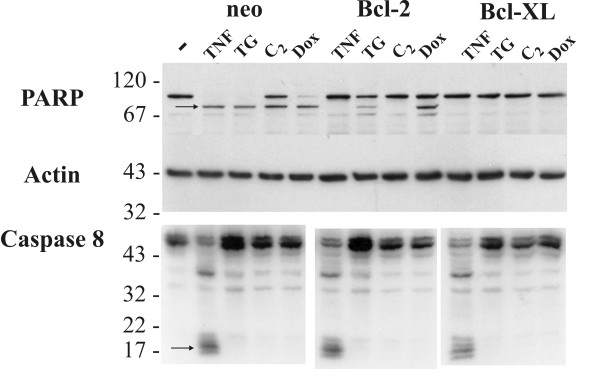
Prevention of apoptosis by Bcl-2 and Bcl-XL in MCF-7 cells. Cell lysates (20 μg of protein) of vector control (neo) and transfected MCF-7 cells expressing Bcl-2 or Bcl-XL (as indicated) were separated by SDS-PAGE, electroblotted and visualized using antibodies for PARP, actin or caspase 8 as indicated. Untreated vector transfected cells (-) as a control for expression level in untreated cells. Expression of Bcl-2 and Bcl-XL does not change the amount of PARP in untreated cells. Cells were exposed to 29 ng/ml TNFα and 10 ng/ml cycloheximide (TNF) (30 h), 400 nM thapsigargin (TG) (60 h), 70 μMC2-ceramide (C2) (20 h), or 10 μM doxorubicin (Dox) (24 h) as indicated above the lanes. The migration of the cleavage products of PARP and caspase 8 are indicated to the left of the bands by arrows. The migration positions of molecular weight markers are indicated in kDa to the left of the panels.